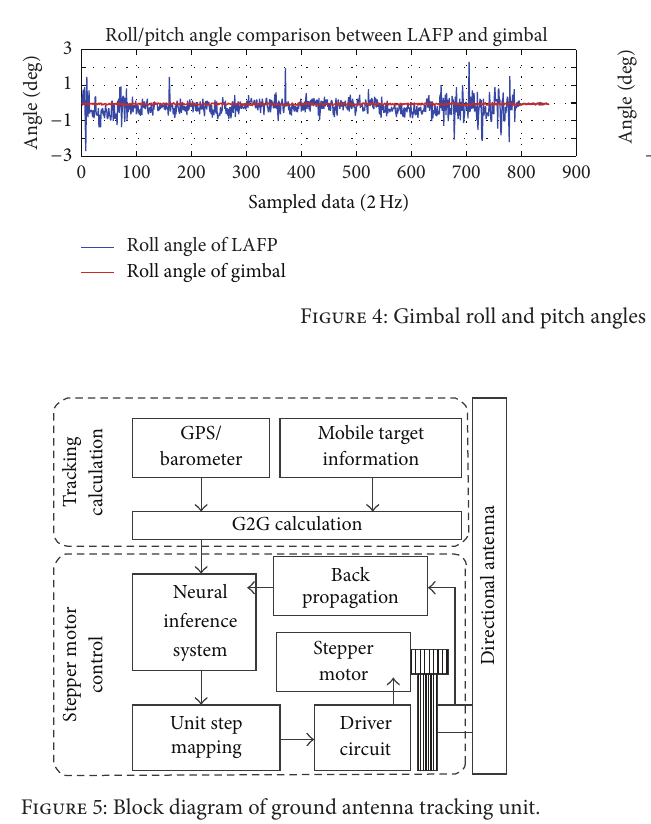
Figure 6: Elevation angle error due to earth